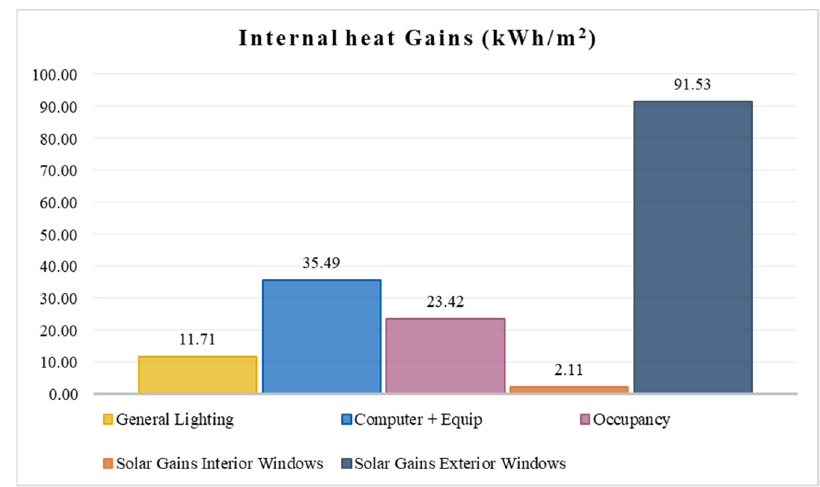
Figure 5. Baseline model energy use distribution of internal heat gain sources.